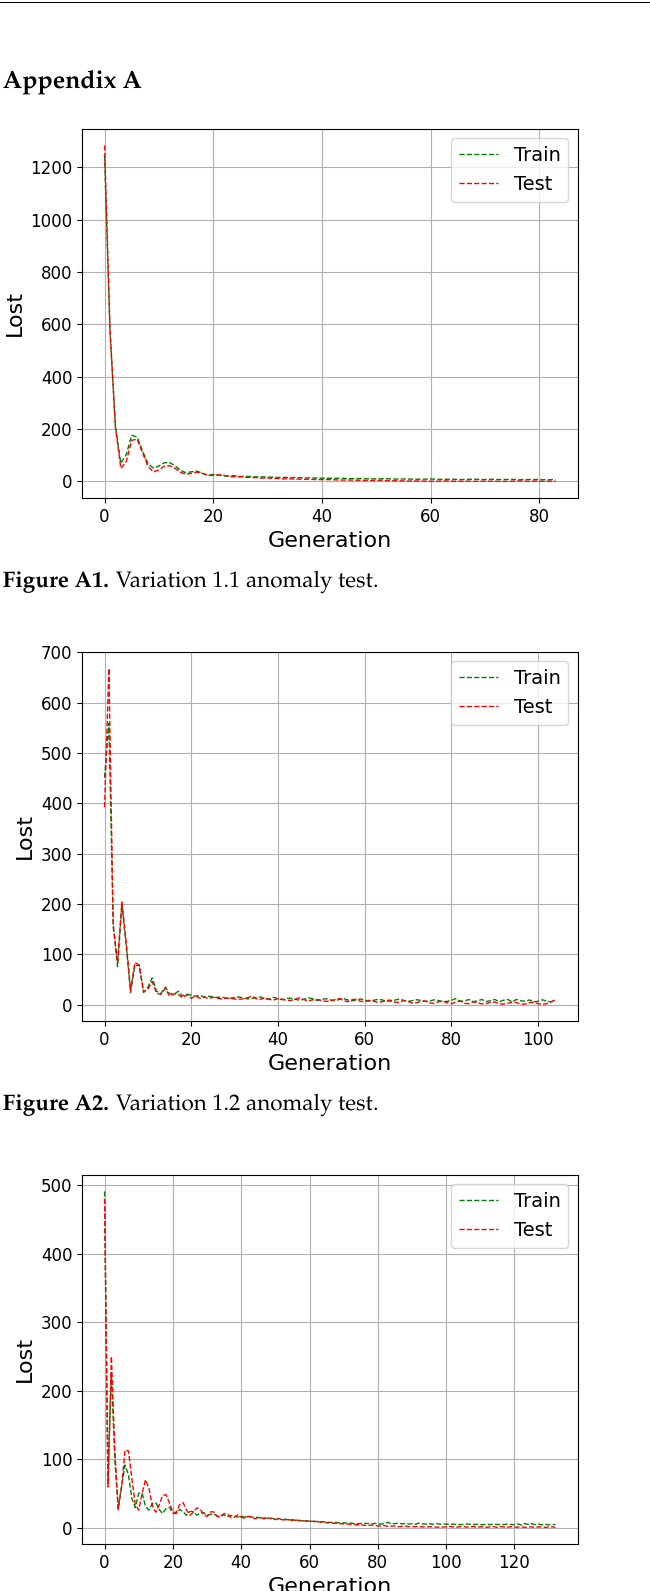
Figure A3. Variation 1.3 anomaly